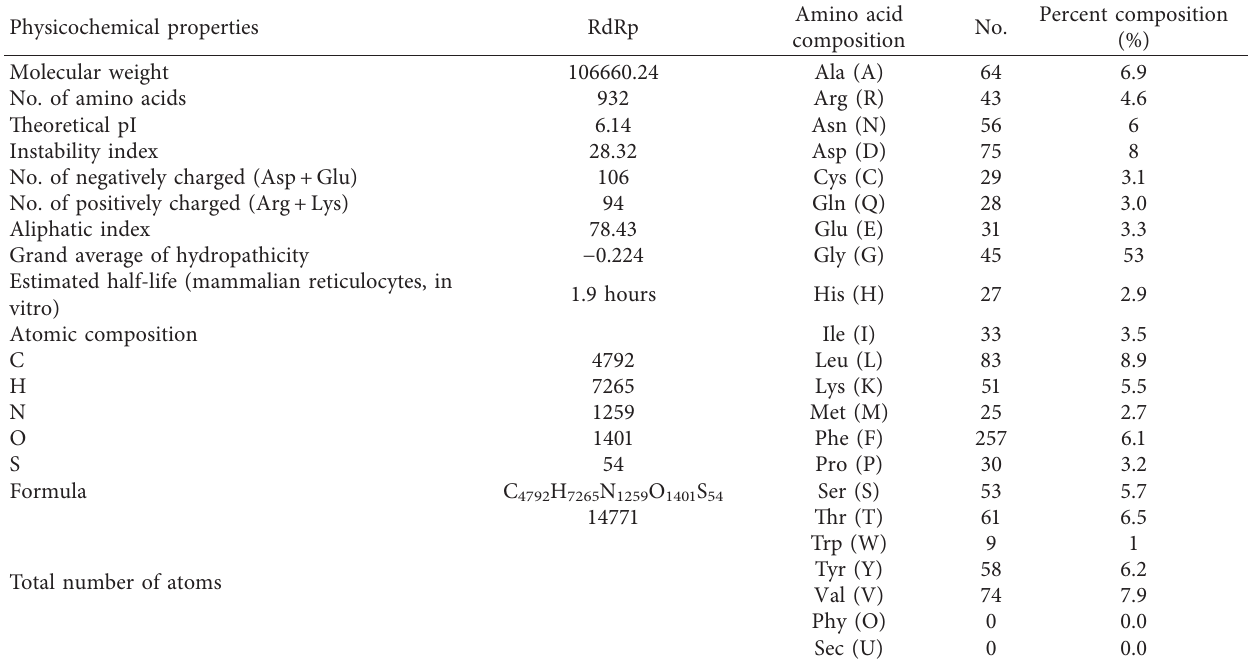
Table 1: Physicochemical properties of RdRp protein (wild